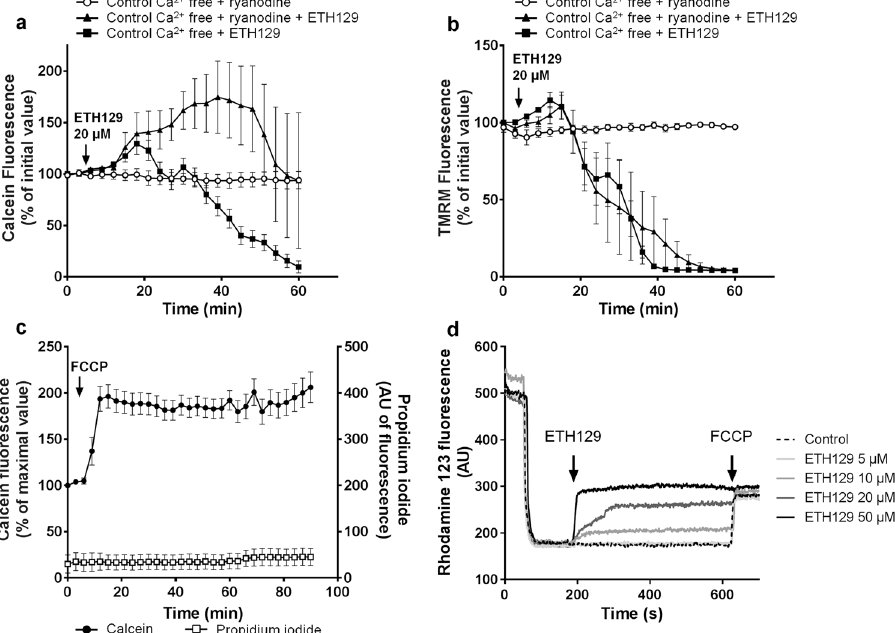
Figure 5. The role of Ca 2 + and of uncoupling in the effect of ETH129. ( a and b ) Isolated mouse adult cardiomyocytes were co-loaded with calcein, CoCl 2 and TMRM at 37 °C and then incubated in a Tyrode’s buffer. After 5 min incubation, 20 µ M ETH129 (arrow) was added to the medium. Prior to experiments, cells were incubated for 40 min in Tyrode’s medium devoid of Ca 2 + supplemented with 20 nM ryanodine to deplete sarcoplasmic reticulum Ca 2 + stocks. ( c ) Isolated mouse adult cardiomyocytes were co-loaded with calcein, CoCl 2 and propidium iodide at 37 °C and then incubated in a Tyrode’s buffer. After 5 min incubation 1 µ M FCCP (arrow) was added to the medium. Fluorescence values were obtained by averaging pixel intensities after background substraction and were normalised as a percentage of the initial value. Each trace represents the mean ± SEM of 3–5 experiments. ( d ) Mitochondrial membrane potential in isolated cardiac mitochondria treated with increasing concentrations of ETH129 was followed by measuring the uptake/release of the fluorescent dye rhodamine 123. Control: 1 µ M FCCP was added to depolarise mitochondrial membrane potential. Curves are representative of at least 4 independent experiments.